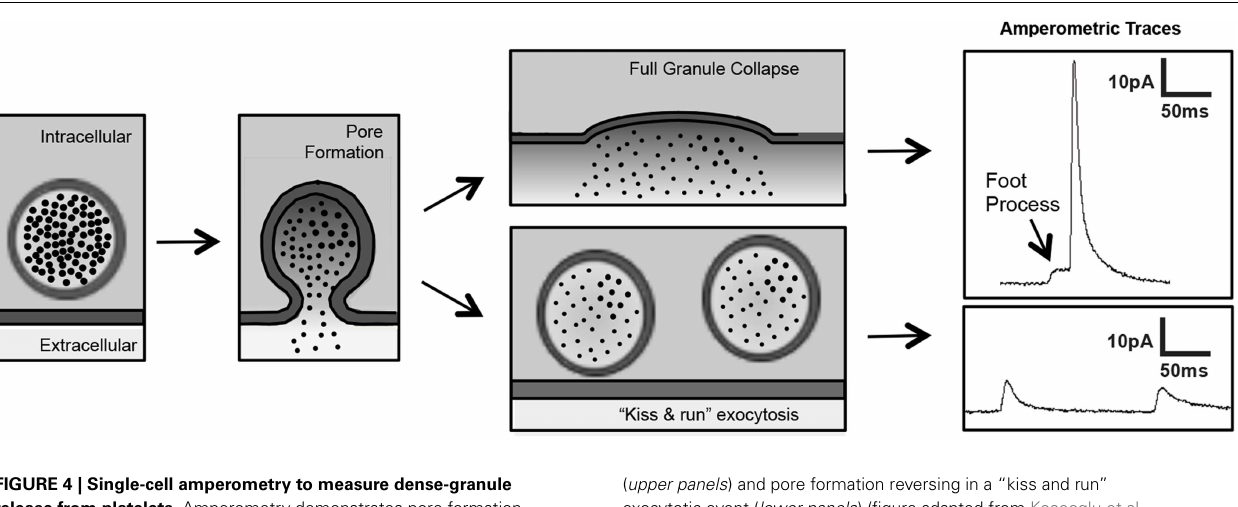
FIGURE 4 | Single-cell amperometry to measure dense-granule release from platelets . Amperometry demonstrates pore formation progressing through a foot process ( left panels ) to full granule collapse